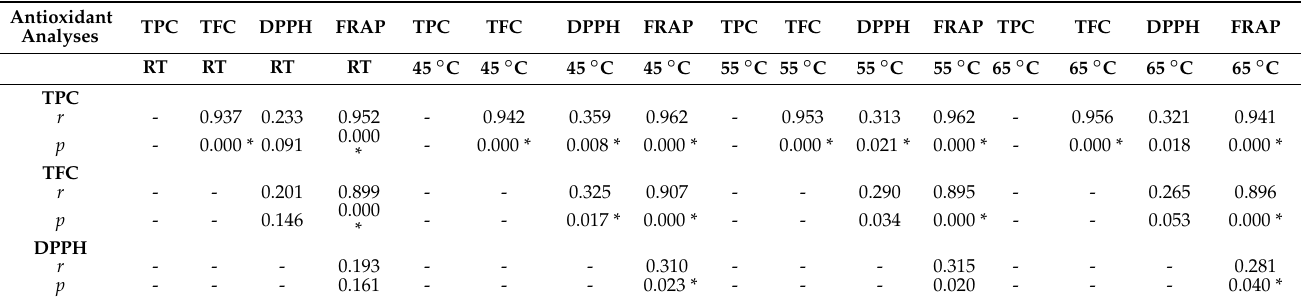
Table 1. Pearson correlation of antioxidant activities for non-heated and the 45 ◦ C, 55 ◦ C and 65 ◦ C heat treatment of SBH from Malaysia and Australia. Antioxidant